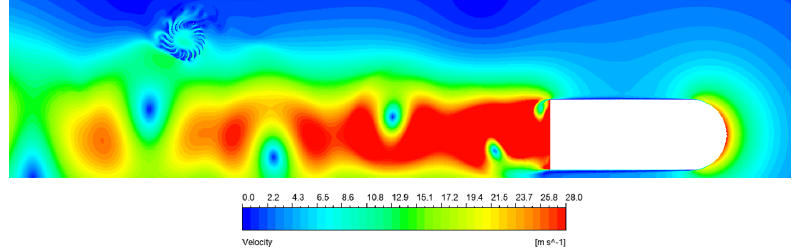
Figure 19. Velocity contours of each car case showing the rear wake taken at t = 3.5 s.